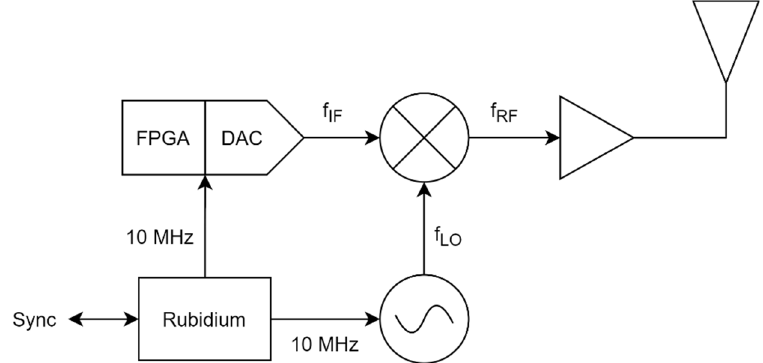
Figure 3. Diagram of the transmitter. Table 1. Hardware components of the transmitter.